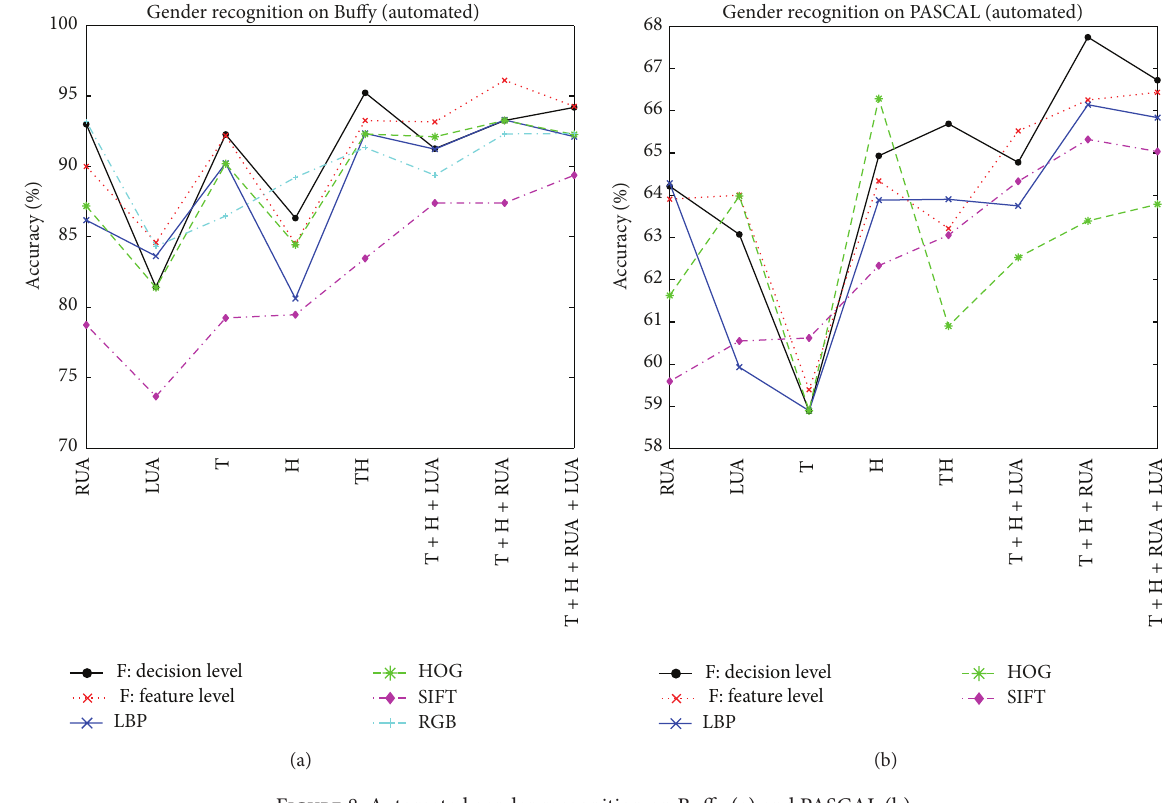
Figure 8: Automated gender recognition on Buffy (a) and PASCAL (b).